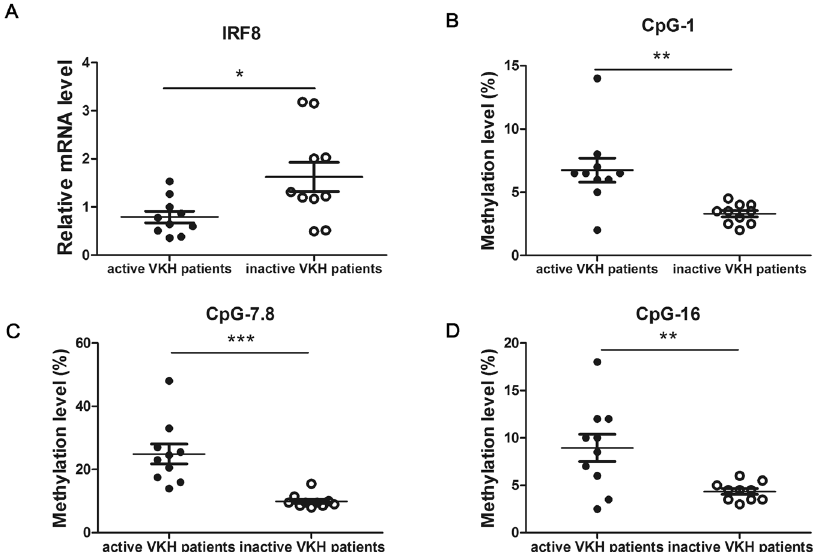
Figure 2. The methylation and the mRNA expression changes of IRF8 affect the activity of VKH patients. ( A ) DCs from inactive and active VKH patients were cultured and collected to detect the expression of IRF8 with real-time PCR (n = 10, * p < 0.05). The methylation changes shown in CpG_1 ( B ), CpG_7.8 ( C ) and CpG_16 ( D ) of inactive VKH patients were notably lower than active patients (n = 10, ** p < 0.01, *** p < 0.001). The data are shown as mean ± SEM. Unpaired t test was used to compare the mRNA level and methylation changes between two